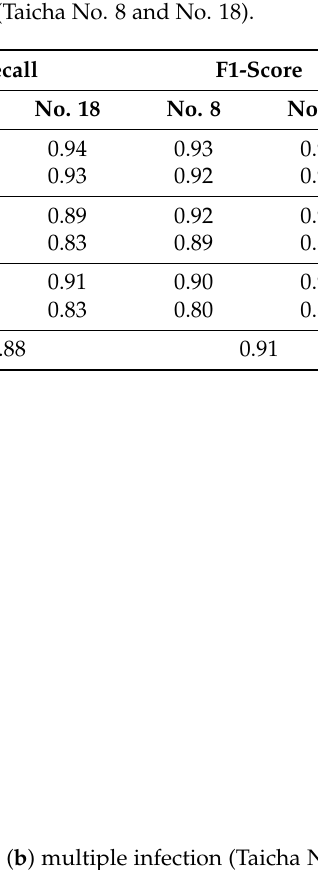
( c ) algal spot; ( d , e ) brown blight leaf disease. Green, light green, and purple coloured frames denote denote brown blight, algal spot, and white spot leaf disease, respectively.